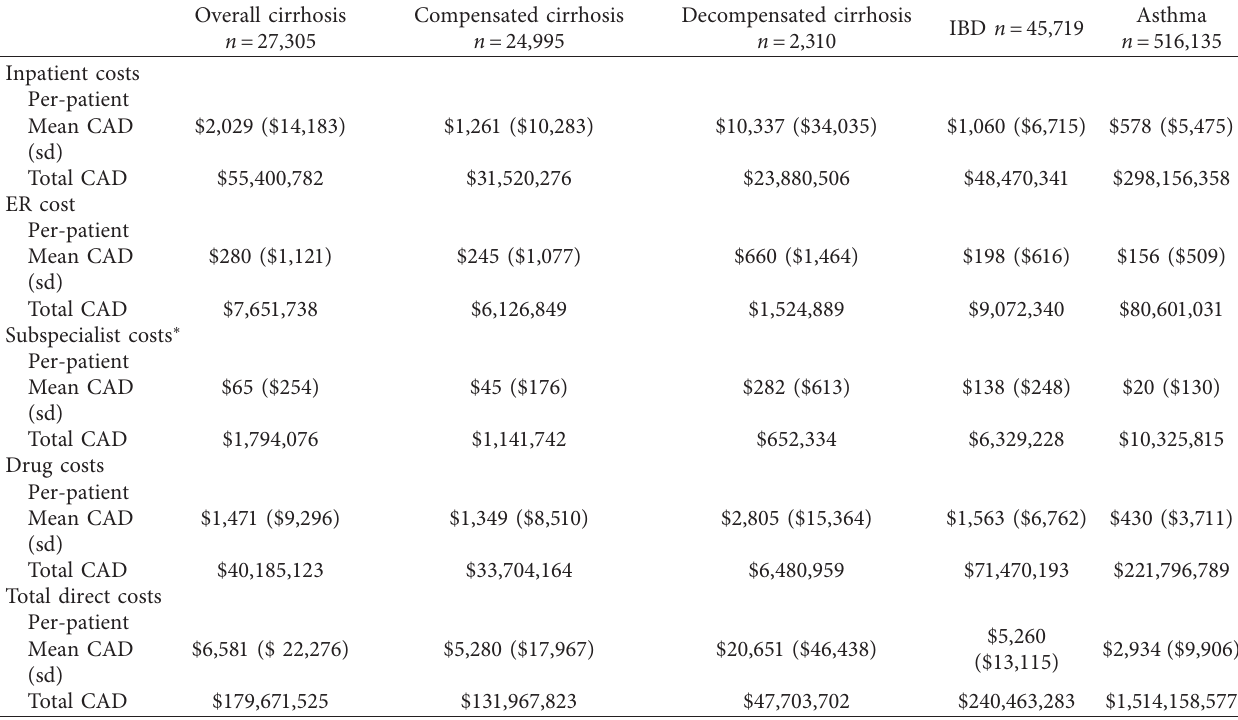
Table 2: Direct per-patient healthcare costs in young adults with cirrhosis, IBD, and asthma in Ontario in